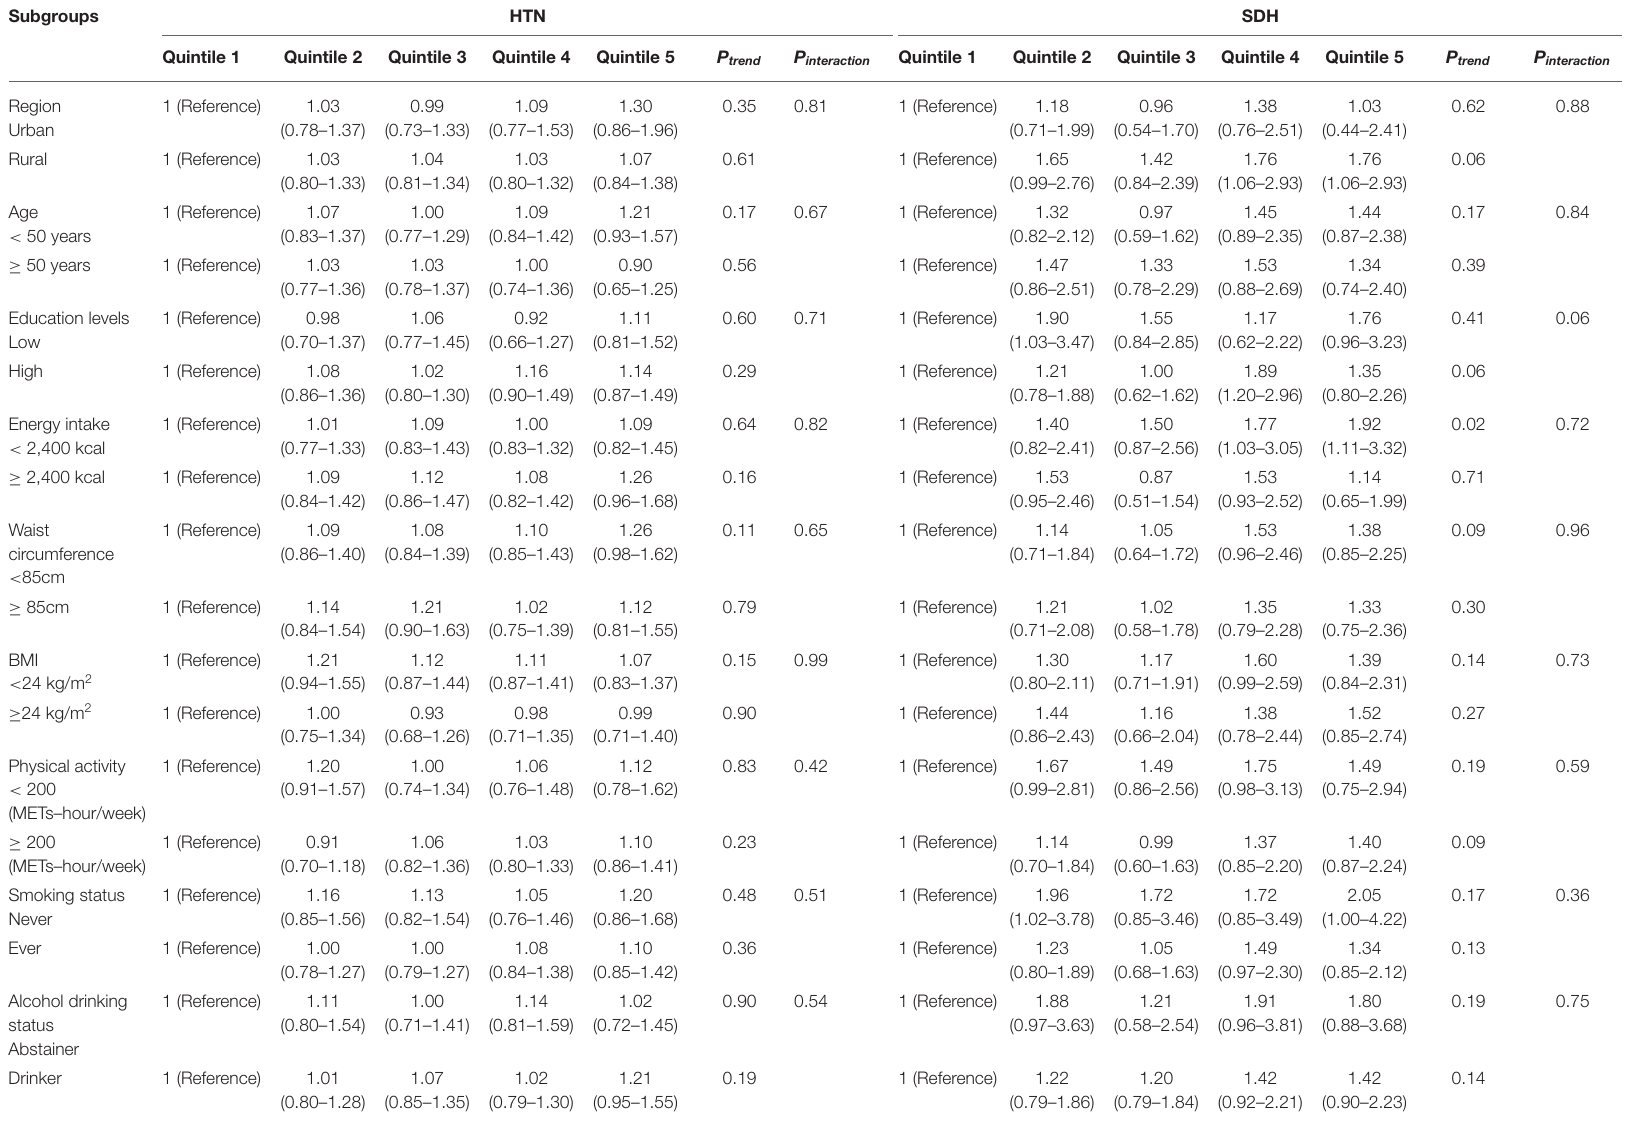
TABLE 4 | Hazard ratios (95% CIs) for HTN and SDH risk for quintiles of carbohydrate in subgroups of men.